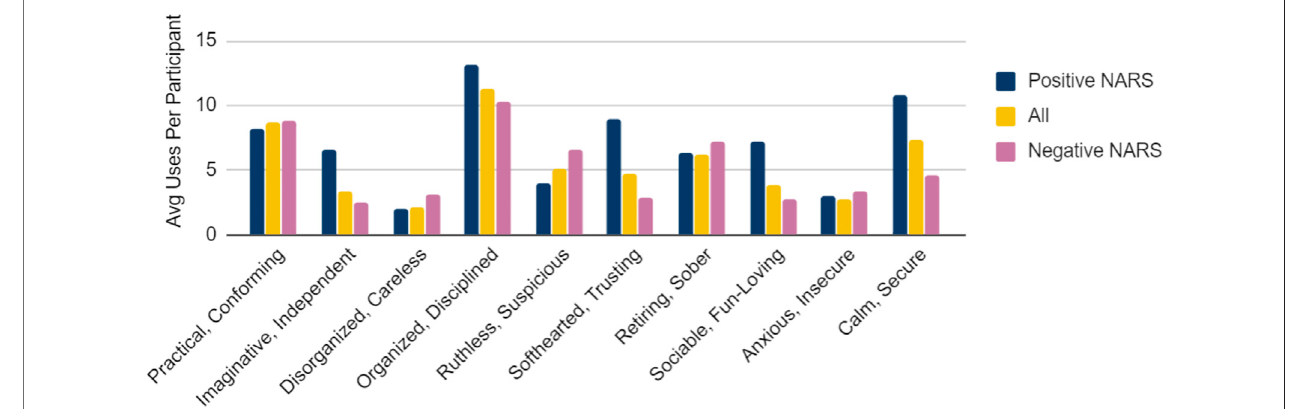
FIGURE5| AveragenumberoftimesapersonalitycategorywaschosenbyaparticipantbasedontheirNARSscore.Theupperboundfornumberofusesis16per participant.